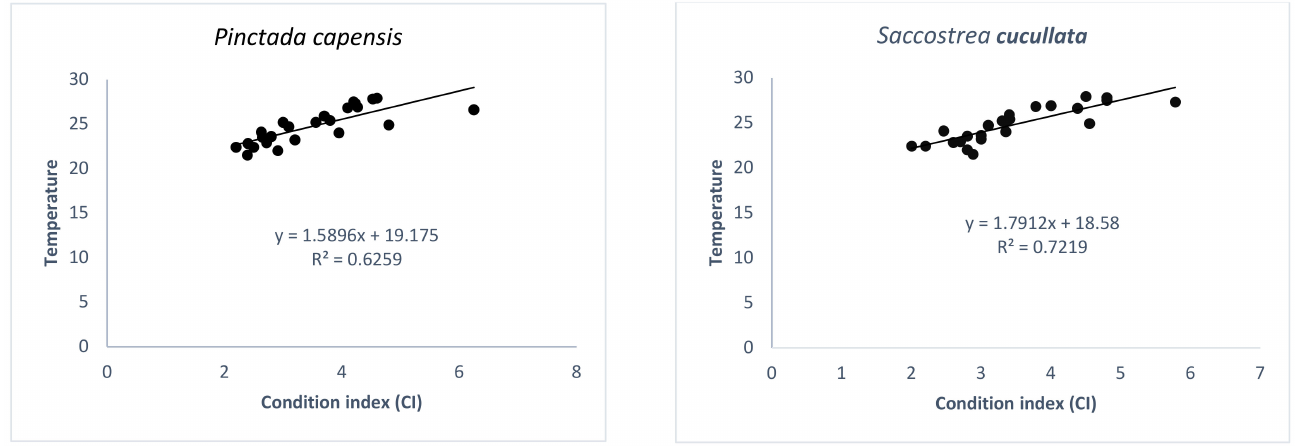
Figure 5. Correlation between temperature and the condition index (CI) of Saccostrea cucullata and Pinctada capensis from Inhaca Island.